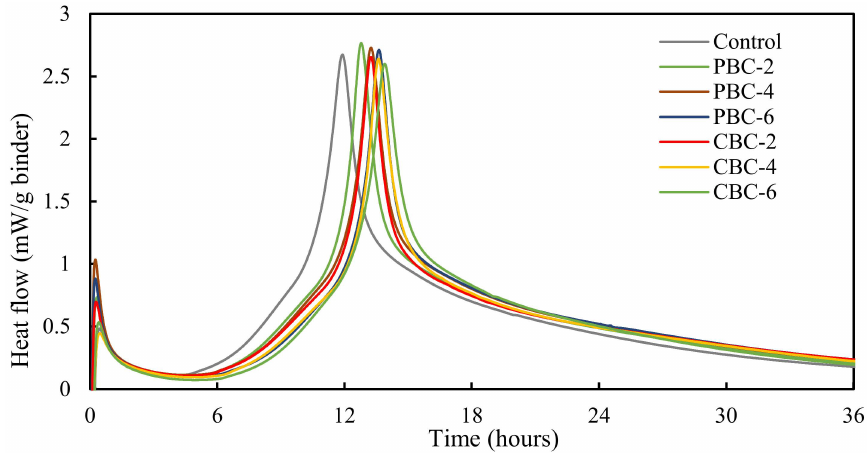
Figure 8. Results of the heat of hydration normalized by the mass of